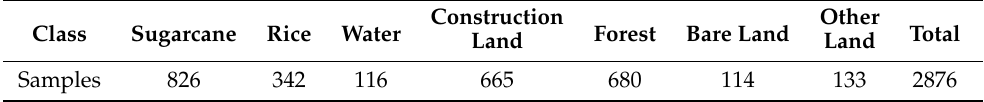
Table 1. Number of field collections of different sample